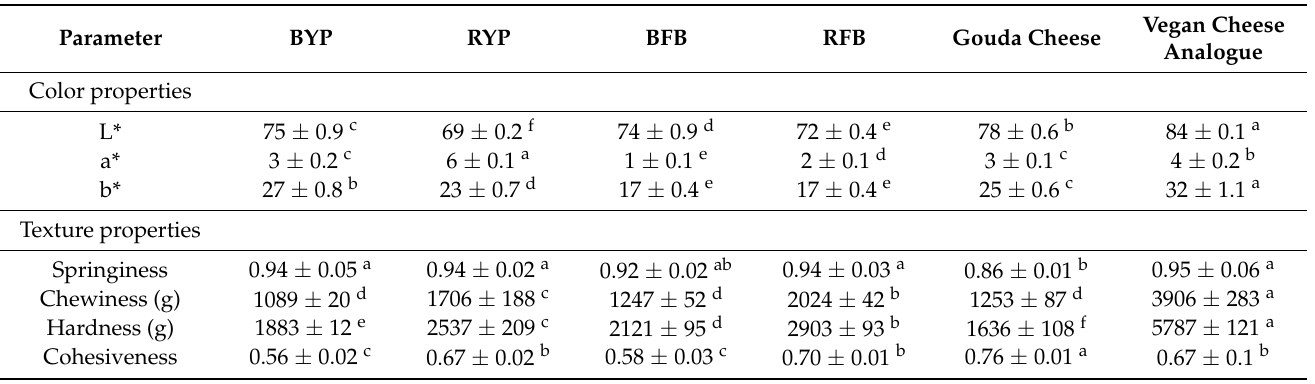
Table 5. Color and texture properties 1 of pulse-based cheese analogues made from different types of pulse flour and the reference products.